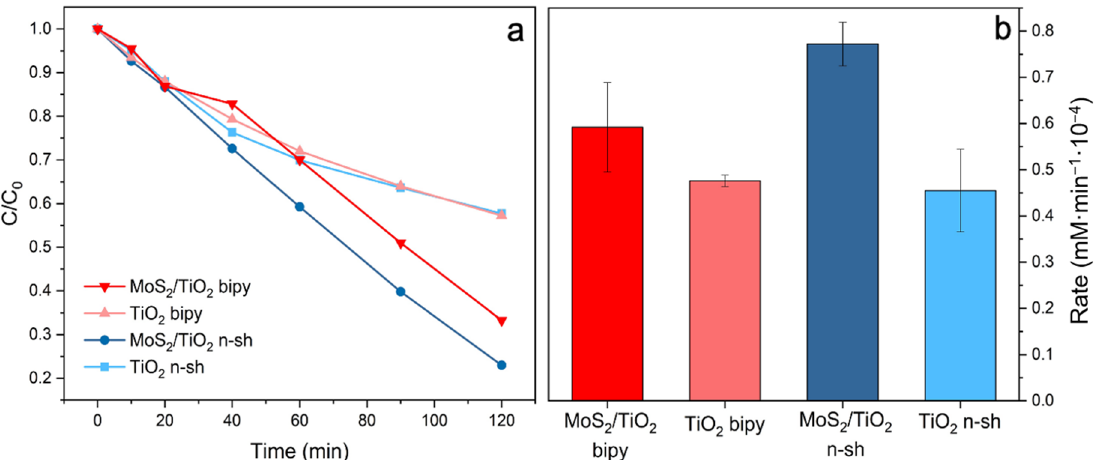
Figure 9. Phenol photocatalytic degradation: ( a ) relationship between C/C 0 and irradiation time; ( b ) decomposition rates of: MoS 2 /TiO 2 bipy (red curve), TiO 2 bipy (light red curve), MoS 2 /TiO 2 n-sh (blue curve), and TiO 2 n-sh (light blue curve).